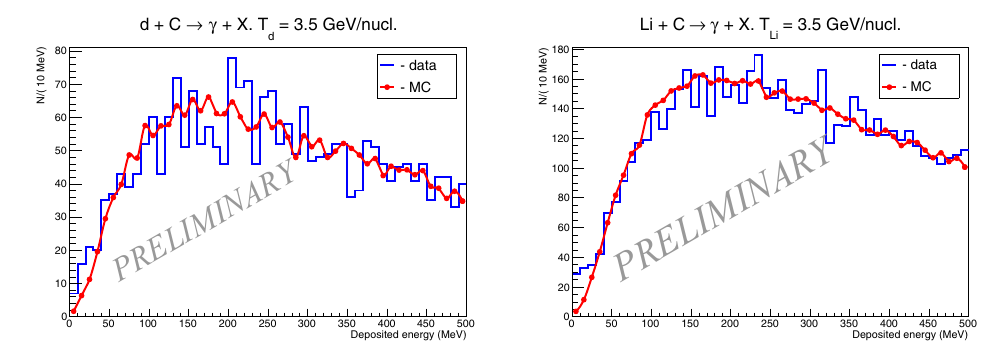
Figure 1. Energy release in BGO calorimeter with a pre-shower in d + C (the left panel) and in Li + C (the right panel) interactions at Nuclotron. Monte Carlo simulation (the red line) and data (the blue